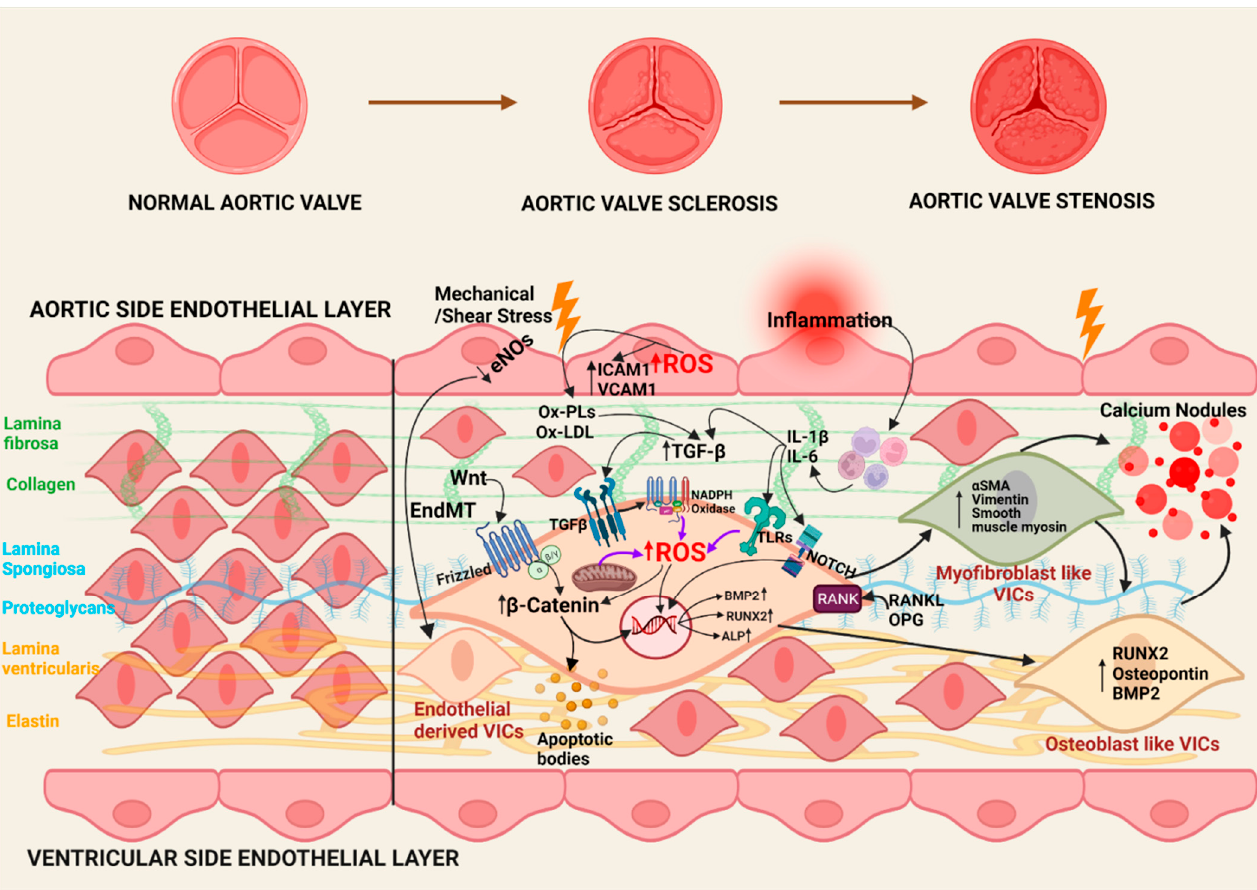
Figure 1. Illustrative diagram of the pathophysiology of CAVS. BMP—bone morphogenic protein, eNOS—endothelial Nitric oxide synthase, ICAM-1—intercellular adhesion molecule 1,